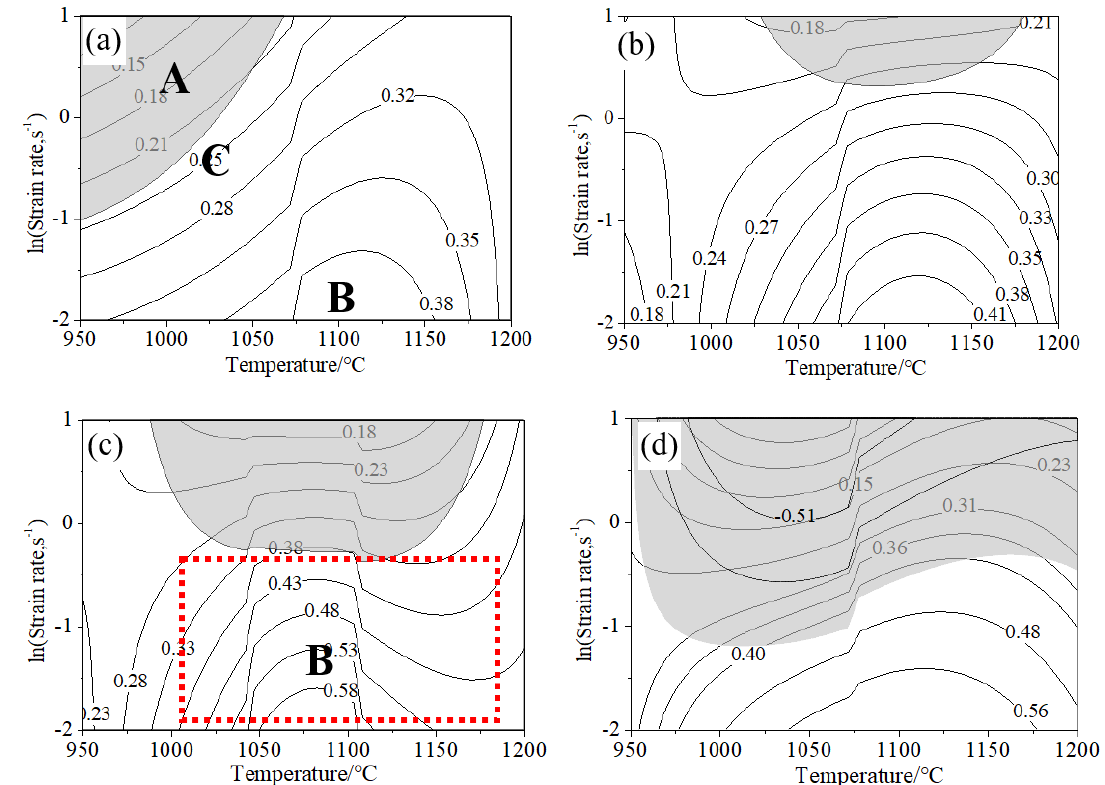
Figure 17. Processing maps for Nickel-based super-alloy of 4W at true strains of ( a ) 0.2, ( b ) 0.4, ( c ) 0.6, ( d ) 0.8. The contour values is power dissipation efficiency expressed in pct.